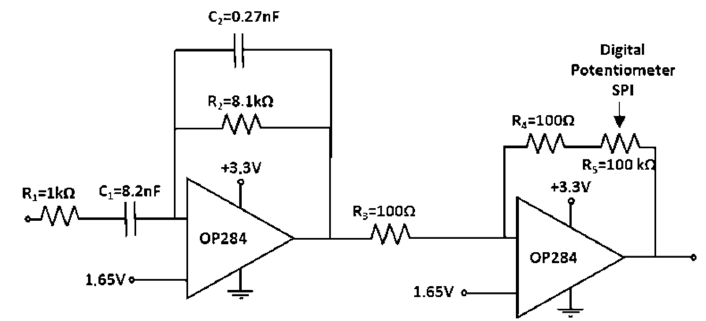
Figure 5. Circuit for the amplification and filtering of the received signal v sum .